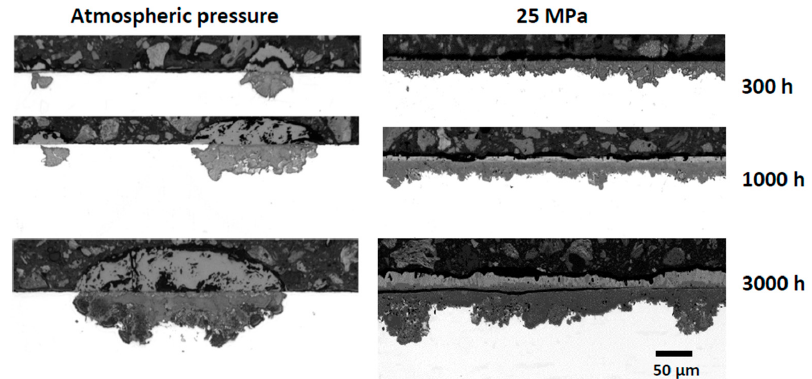
Figure 7. Light microscope cross section of HT347HFG specimens exposed to steam at 700 °C as a function of time and pressure.